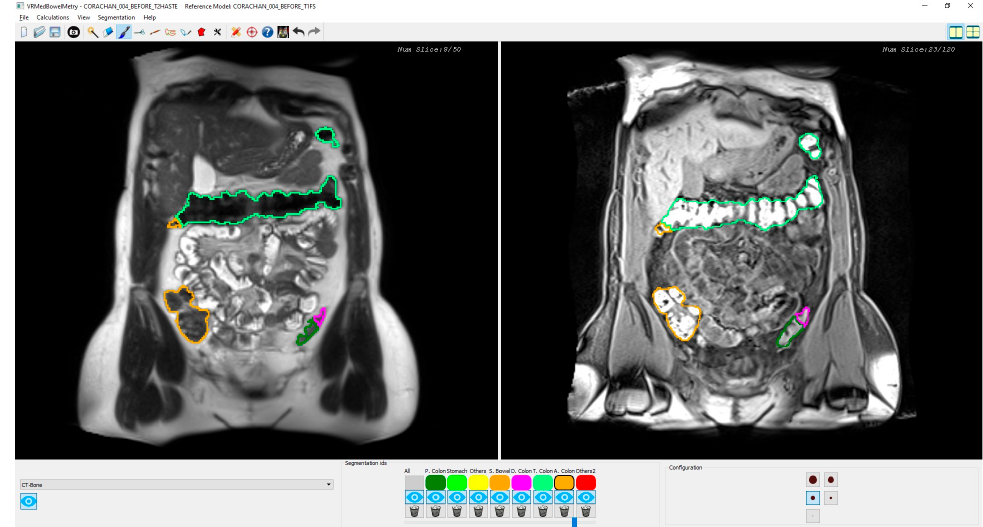
Figure 3. Snapshot of the synchronized T2 and T1-FS module. On the left side, an original T2 image is shown with the colon segmentation outlined using a different color for each segment. On the right side, the same visualization scheme is used with its corresponding original T1-FS image.